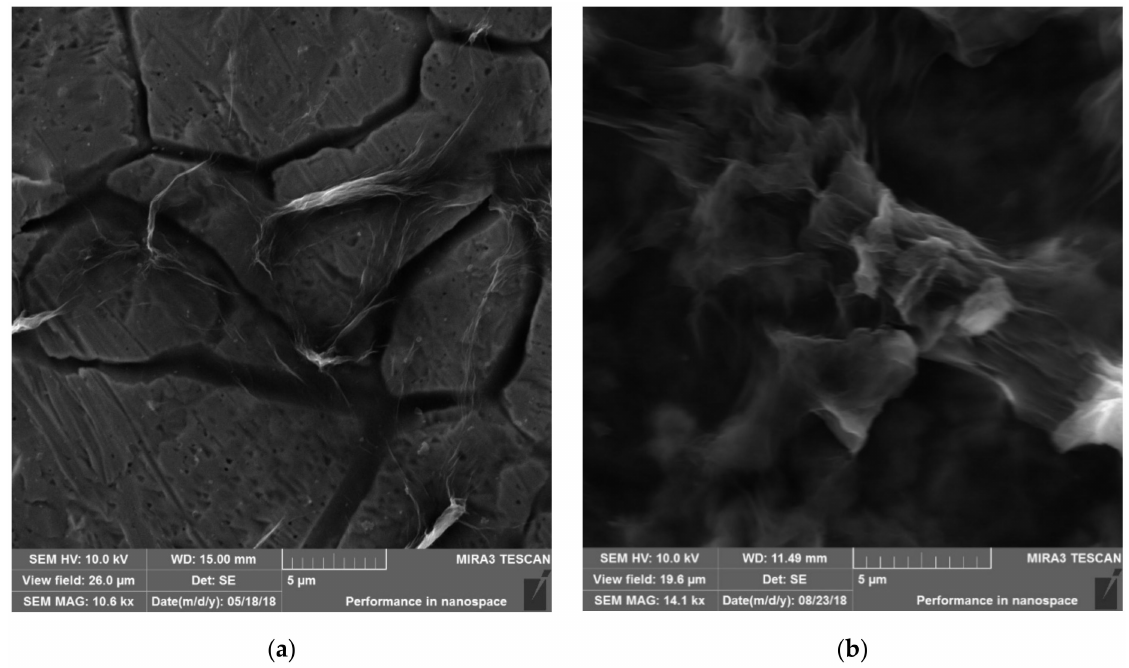
Figure 12. ( a ) First deposition of GO by EPD, magnification 10.6 kx, ( b ) third deposition of GO by EPD, magnification 14.1